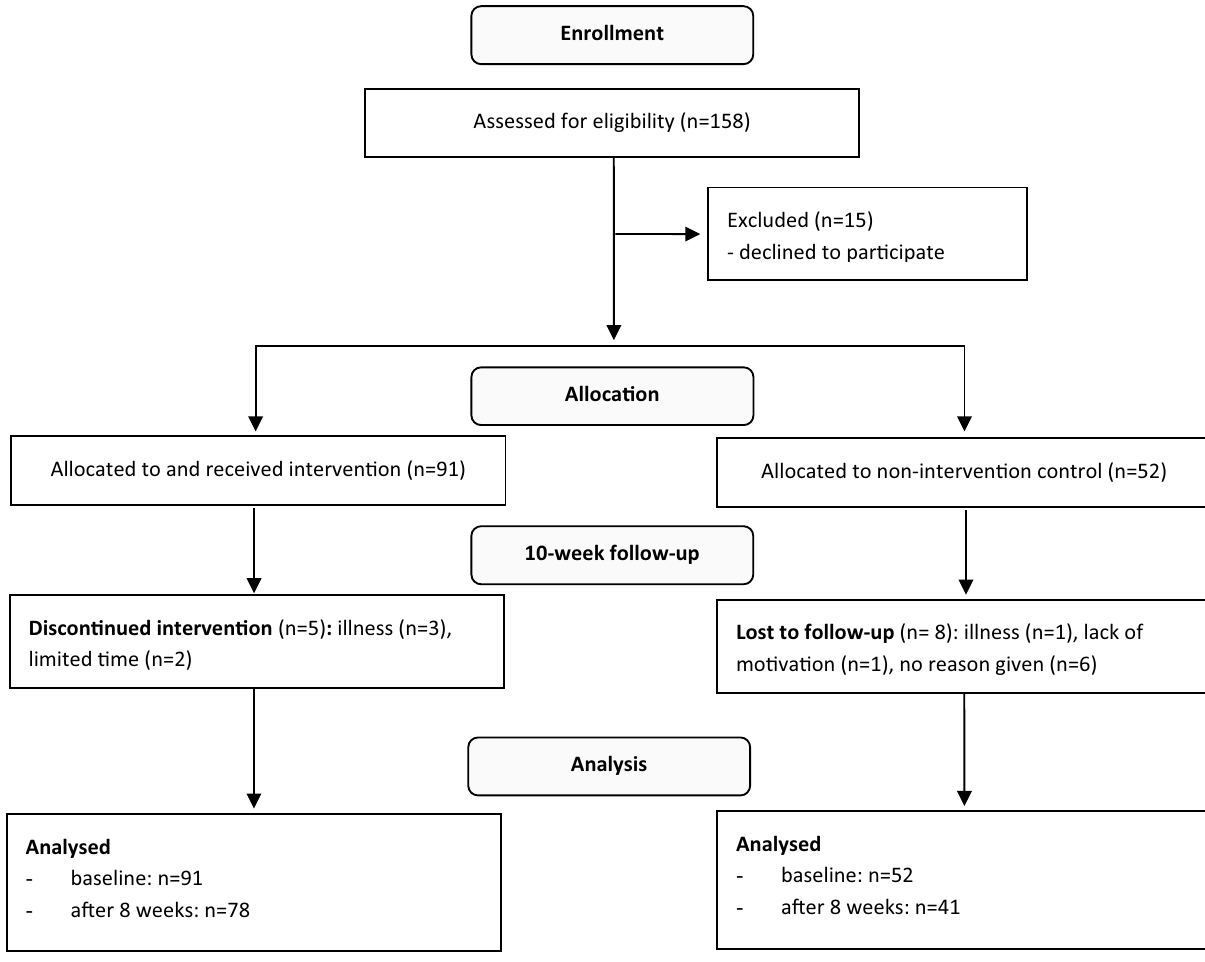
Figure 1. CONSORT structure participants’ flow diagram; participants categorized as “lost to follow-up” withdraw from the study with the given reason. In the IG, information is given on how many participants discontinued the intervention (e.g. dropped out) and